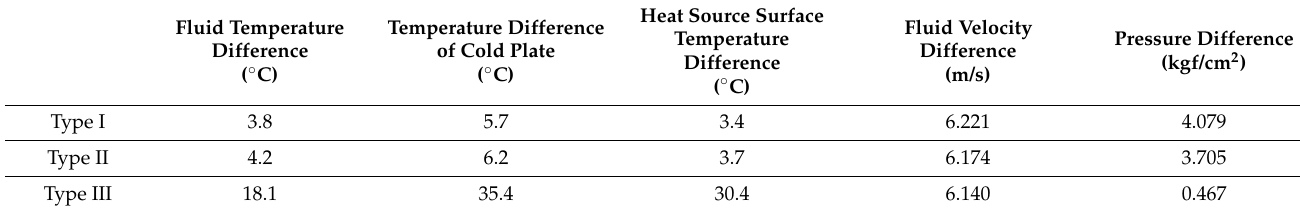
Table 2. Comparison of outlet and inlet position status differences.